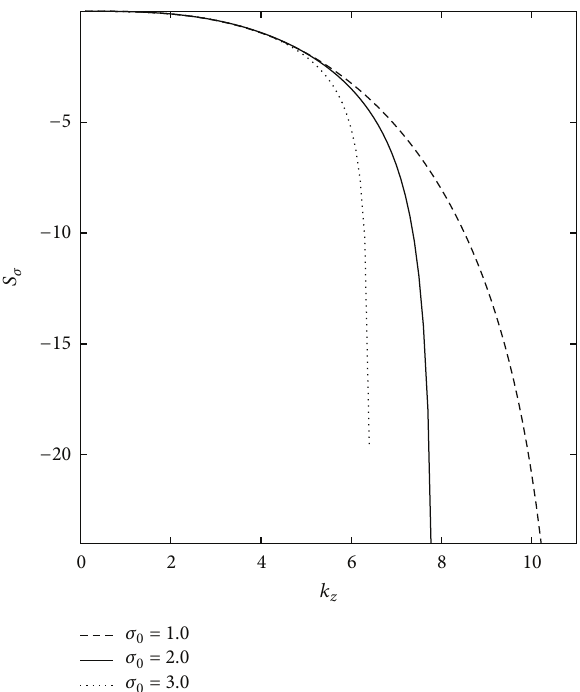
Figure 4: Sensitivity function 𝑆 𝜎 versus zonal wavenumber 𝑘 𝑧 for different nominal values of the static stability parameter 𝜎 0 (units 10 6 m 2 Pa −2 s −2